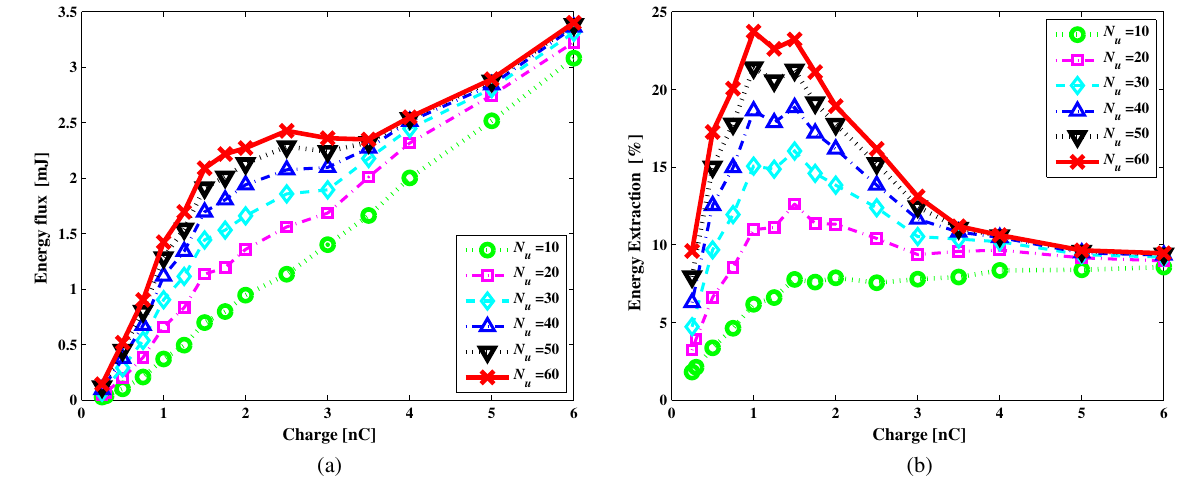
FIG. 7. Charge dependence of radiation energy flux (a) and energy efficiency (b).